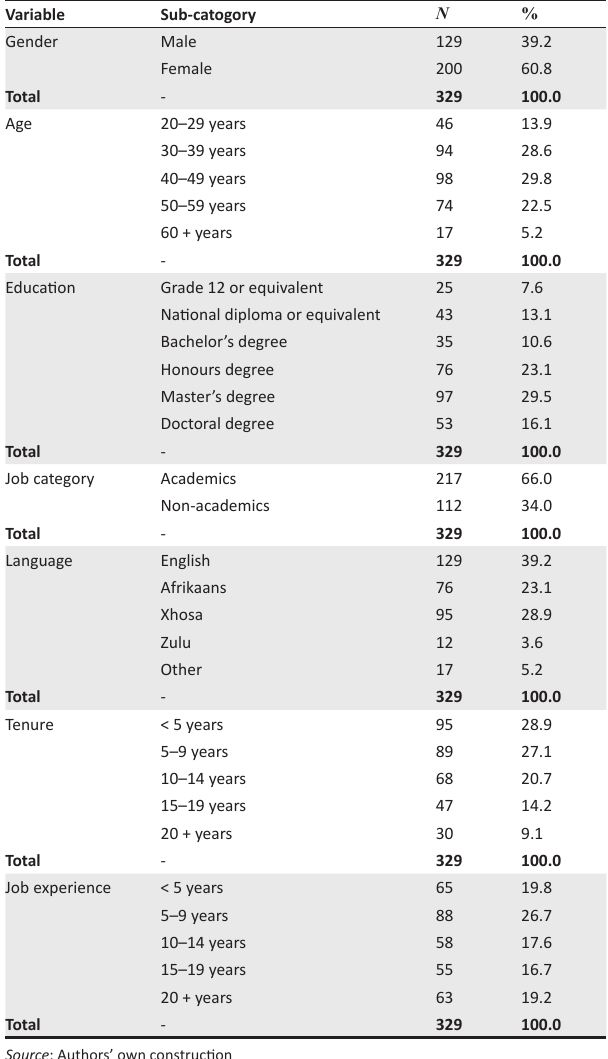
TABLE 1: Demographic composition of